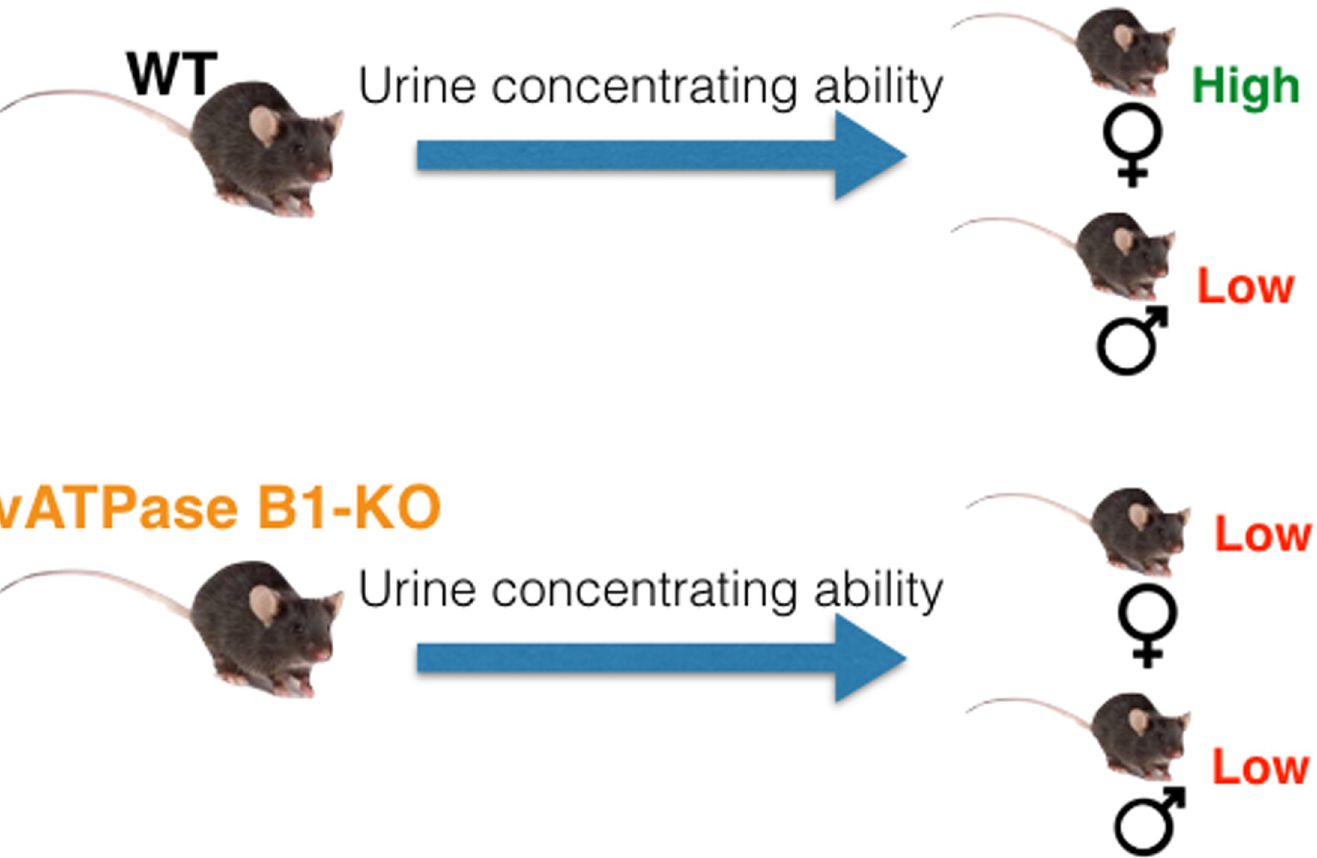
Fig 8. Schema depicting the overall difference in water regulation in the Atp6v1b1 -/- mice compared to WT. Ablation of the V-ATPase B1 subunit decreases the urine concentrating ability of mice both under baseline conditions and after dehydration. Loss of the B1 subunit eliminates the apparent advantage in water concentrating ability of female animals over the male animals that was found in WT